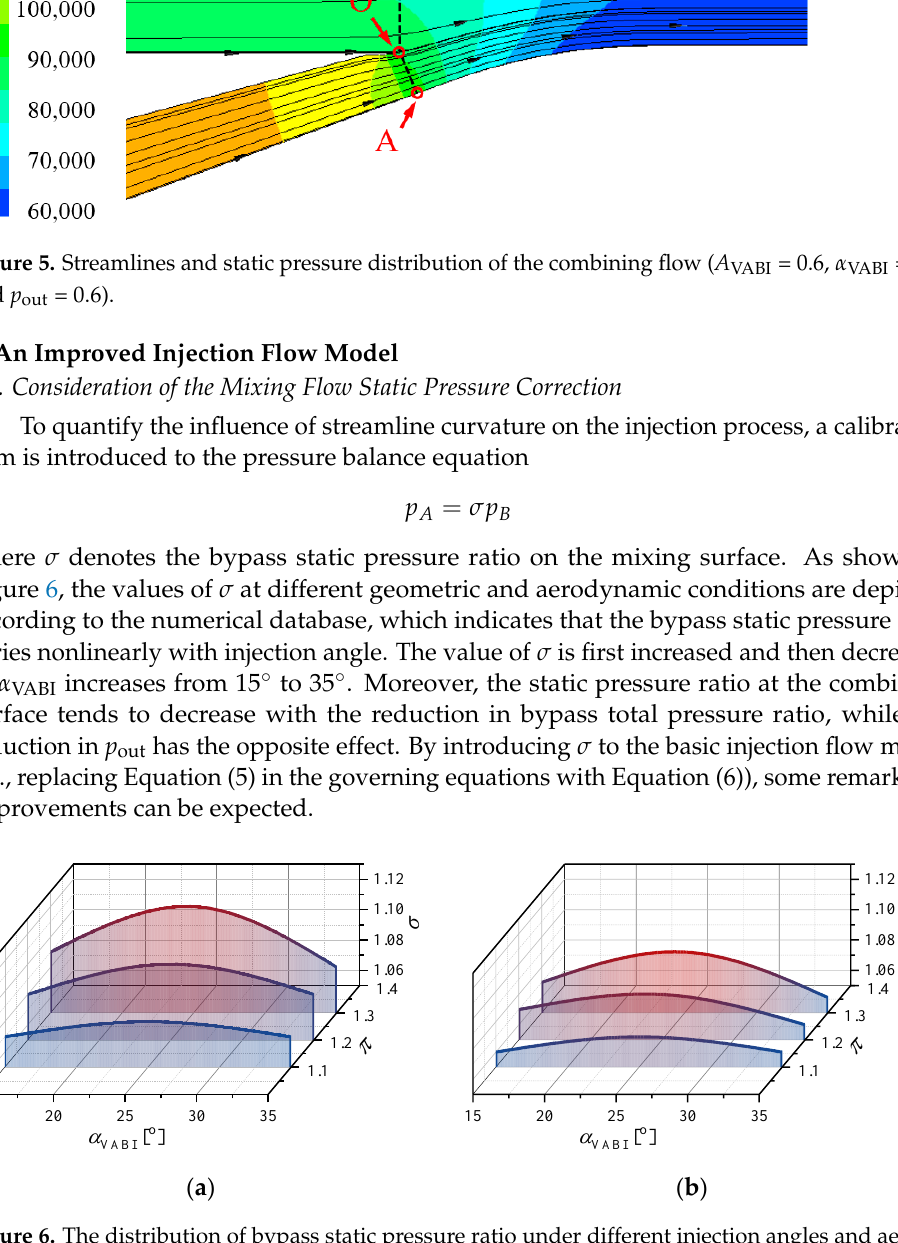
Figure 6. The distribution of bypass static pressure ratio under different injection angles and aerody- namic conditions ( A VABI = 0.6): ( a ) p out = 0.6; ( b ) p out =